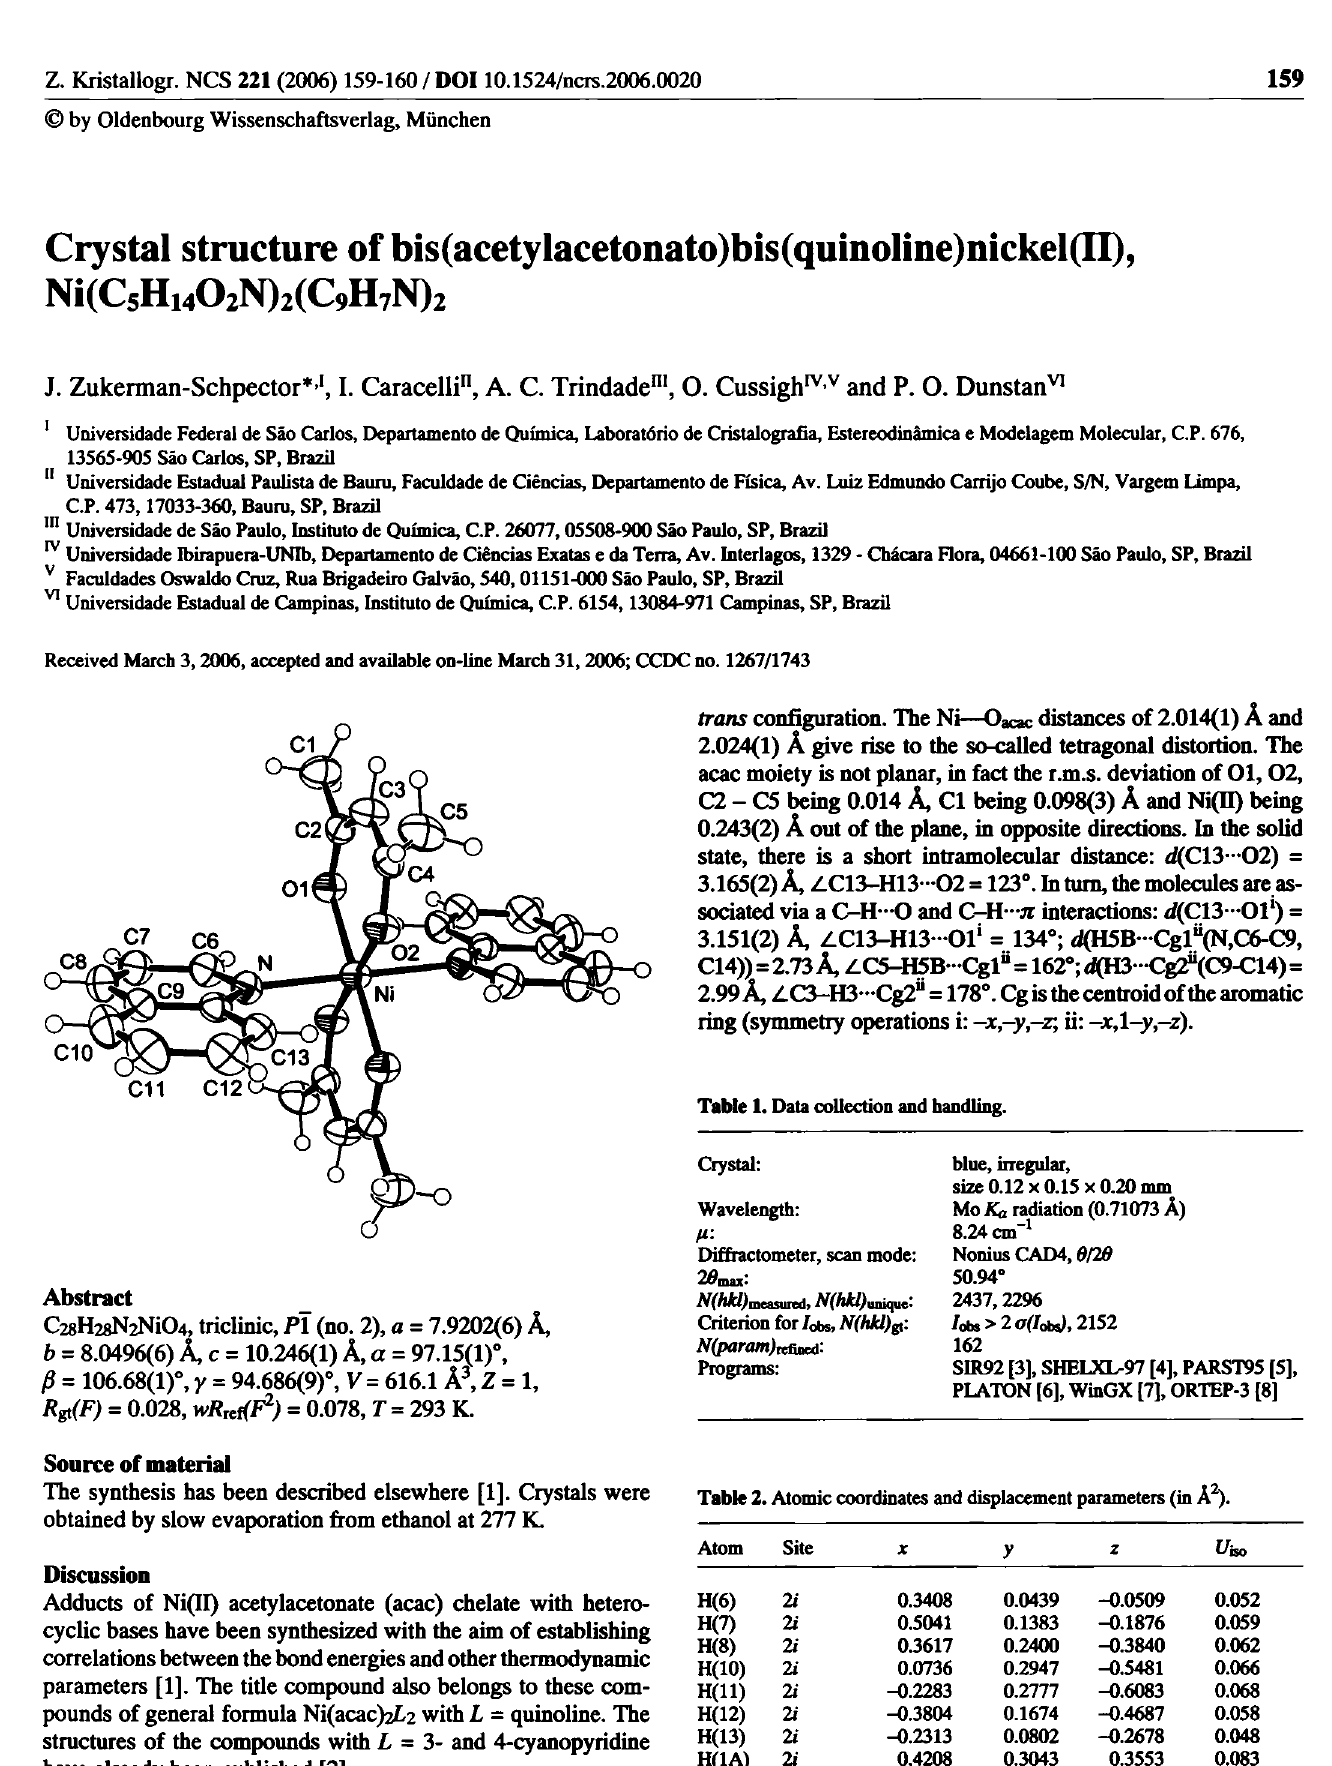
Table 2. Atomic coordinates and displacement parameters (in Ä 2